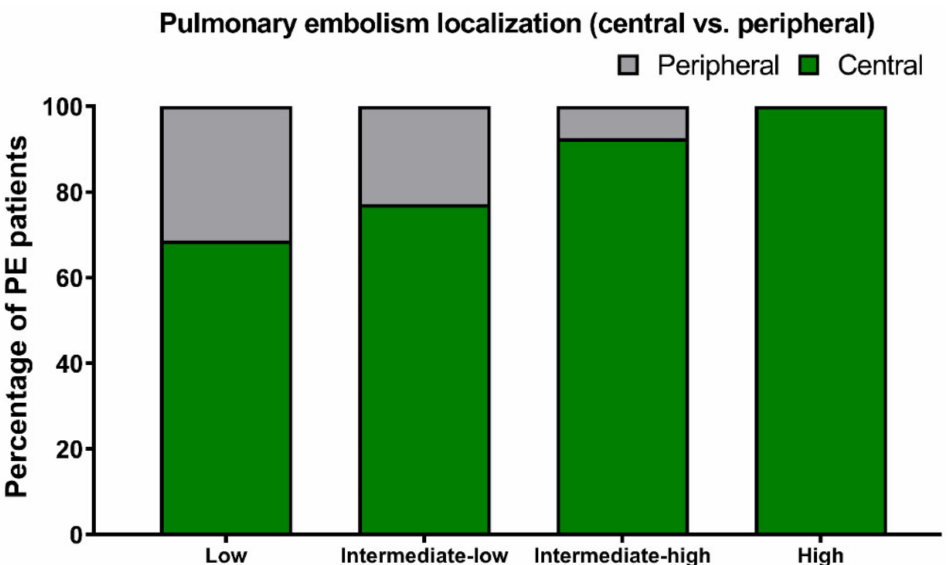
Figure 3. Pulmonary embolism localization (central vs. peripheral) according to the risk of early